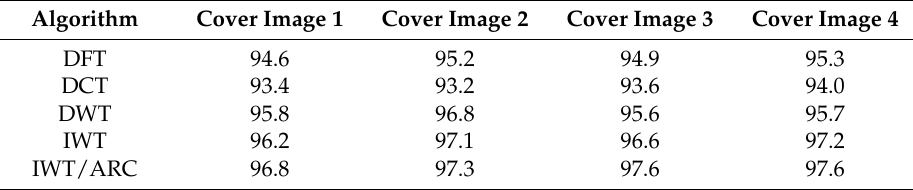
Table 4. Accuracy comparisons of the proposed system for various algorithms.